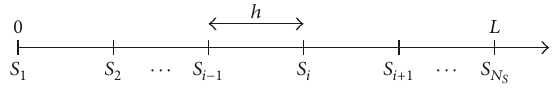
Figure 1: Uniform grid with a spatial step size ℎ